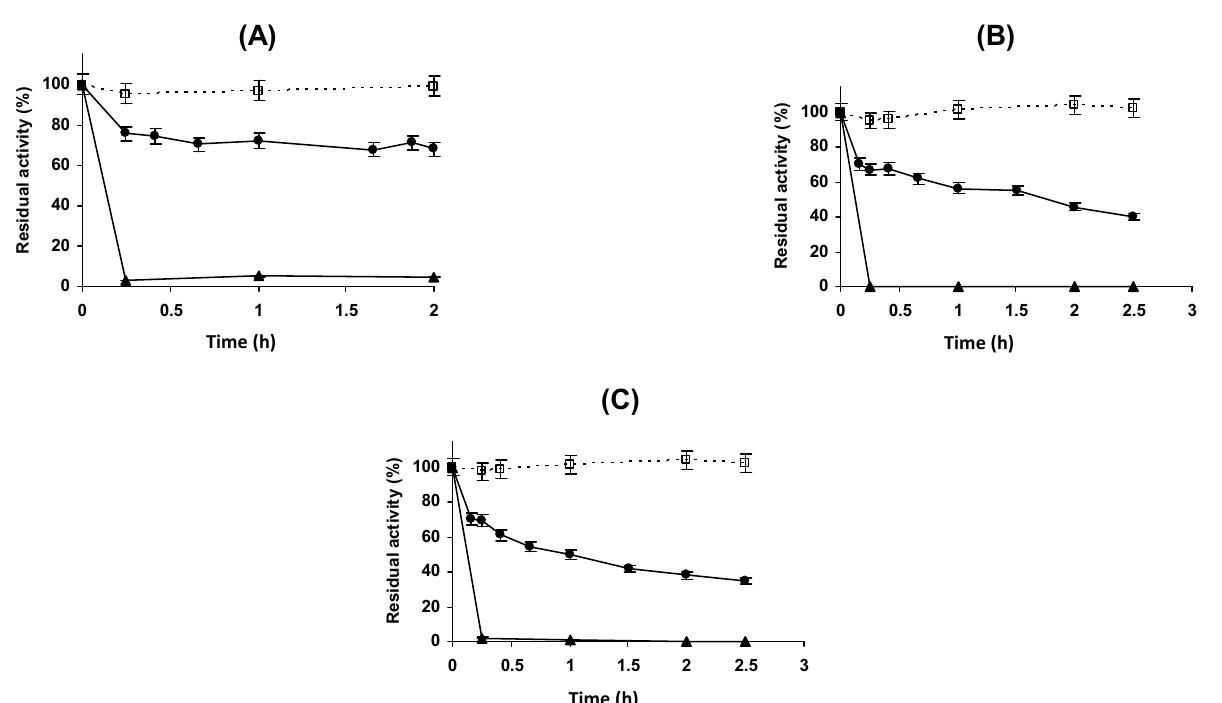
Figure 8. Immobilization courses of r Aae UPO at 25 °C and pH 7.0 on ( A ) MANAE agarose support, ( B ) PEI (10,000) agarose and ( C ) PEI (25,000) agarose. Other specifications can be found in the Methods section. Full circles: suspension; full triangles: supernatant; empty squares with dotted line: reference.